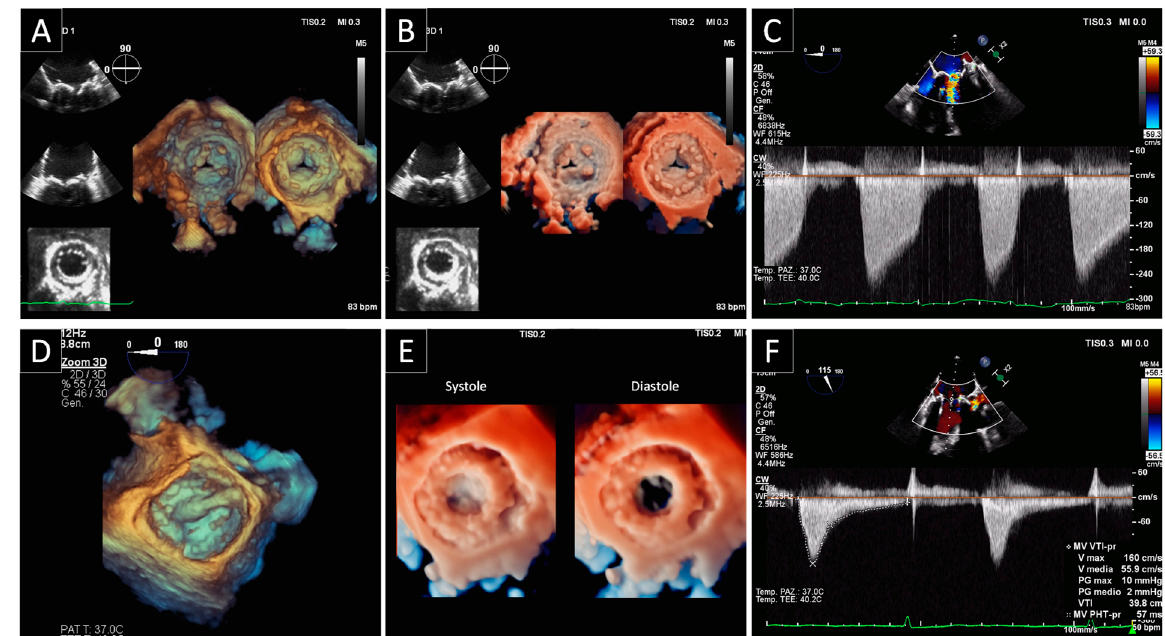
Figure 5. SVD of a biological prosthesis in mitral position treated with valve-in-valve procedure. ( A ) Standard 2D and 3D TEE rendering and ( B ) 3D transillumination technique of a bioprosthetic mitral valve from atrial and ventricular perspective demonstrating leaflets thickening and immobility. The SVD causes incomplete opening of two of the cusps and therefore results in a reduced anatomic and effective orifice area. ( C ) Increased transprosthetic gradient and pathological PHT at continuous wave Doppler by TEE. ( D ) Transseptal positioning of the transcatheter PV displayed from the left atrium using 3D TEE rendering during the valve-in-valve procedure. ( E ) Fully deployed mitral valve-in-valve in systole and diastole depicted using transillumination technique. ( F ) Normalization of transprosthetic gradient and PHT at continuous wave Doppler by TEE.